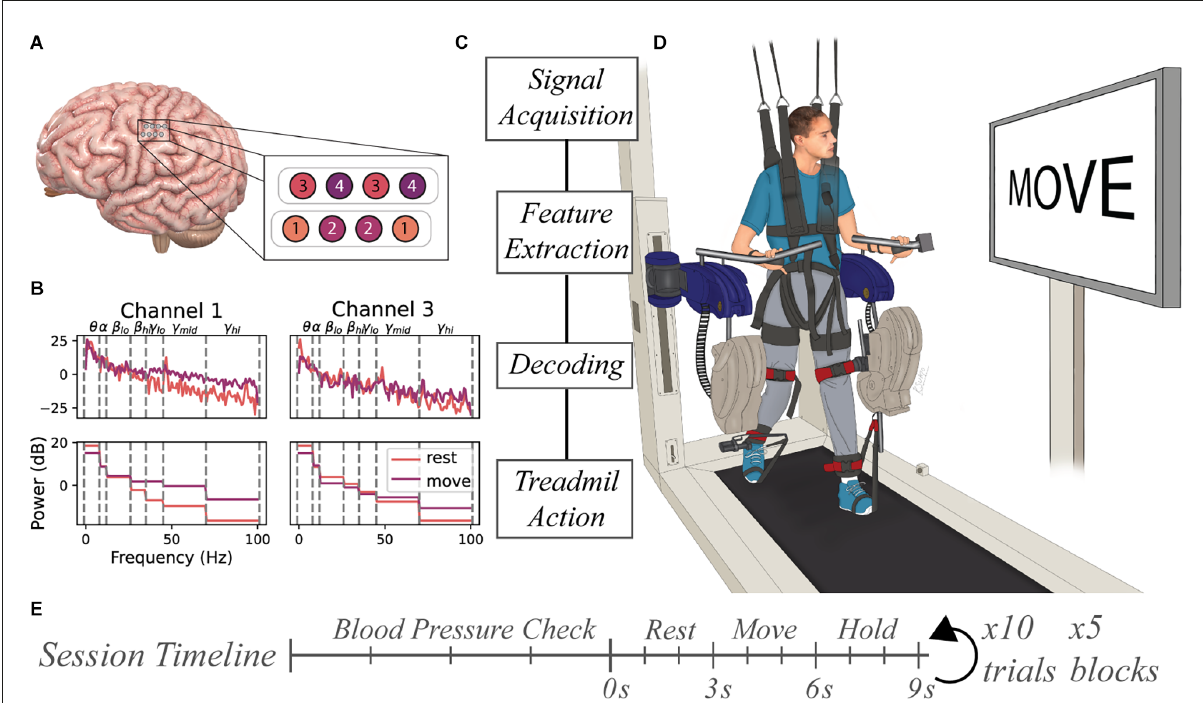
FIGURE1 Experimental setup for BCI-controlled ReoAmbulator. (A) Two 4-contact electrode strips were implanted over the hand region of the sensorimotor cortex. The electrodes were configured in a bipolar mode resulting in four channels of ECoG data. (B) Features were